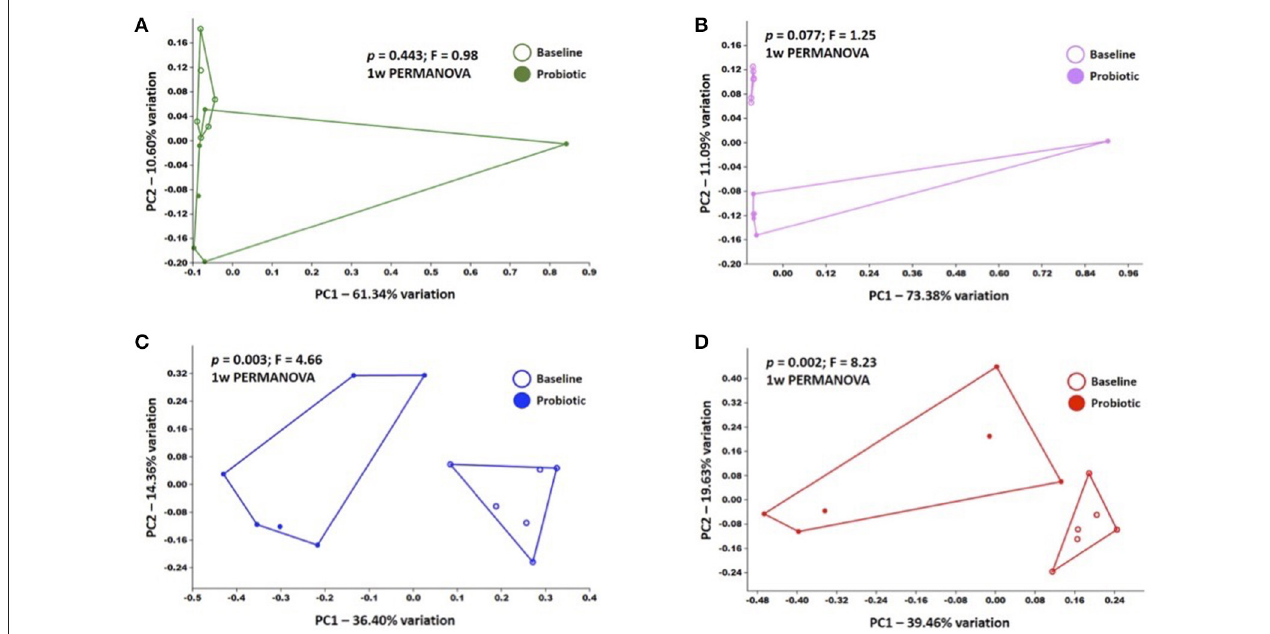
FIGURE 3 | Principal coordinate analyses of baseline and post-administration (Probiotic) samples within each sample site, including rectal swabs (A) , OP swabs (B) , bronchoalveolar lavage fluid (BALF) (C) , and blood (D) ; legends at right of each plot. p and F values determined via one way PERMANOVA of Bray-Curtis distances.